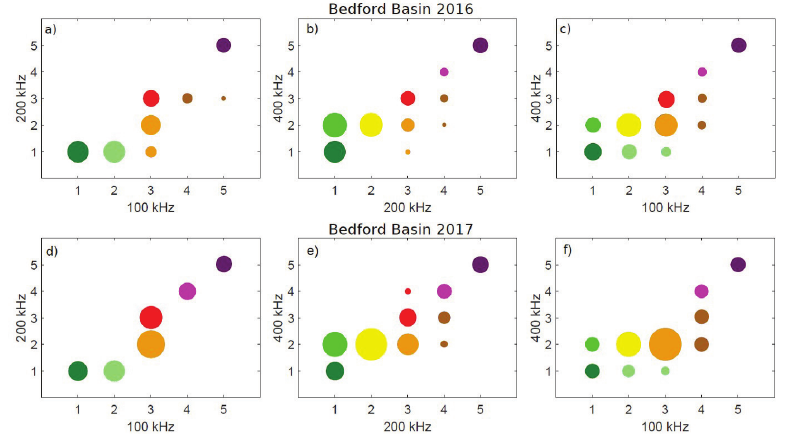
Figure 12. MACs of the Bedford Basin datasets 2016 and 2017. MAC revealed by the AC combinations of ( a , d ) 100 and 200, ( b , e ) 200 and 400, and ( c , f ) 100 and 400 kHz. The colors indicate the different MACs. The corresponding legend is displayed in Figure